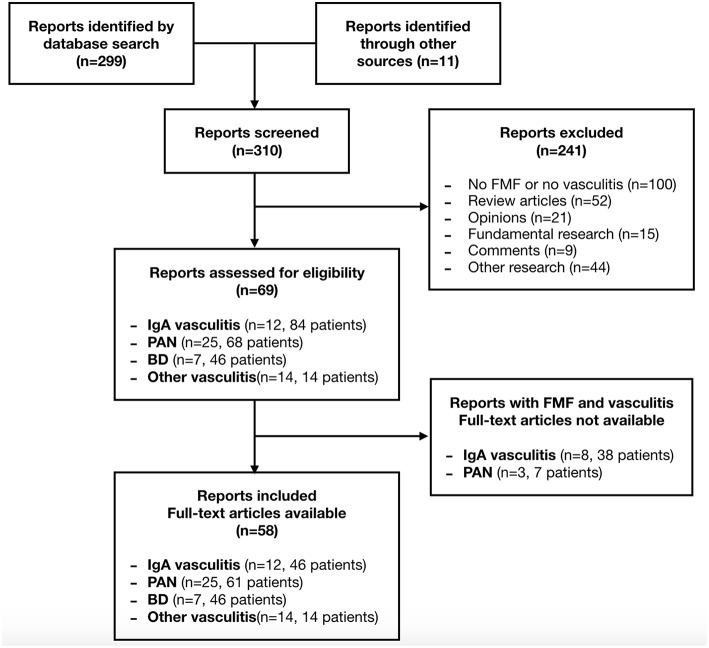
Flow diagram of the article selection process.